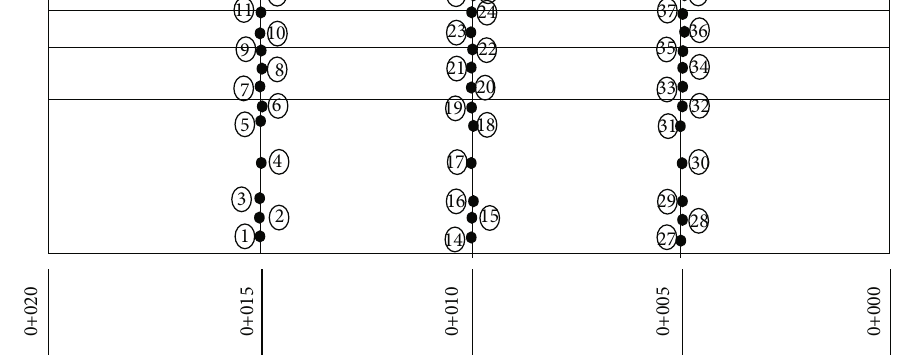
Figure 9: The planar layout of pressure pints.